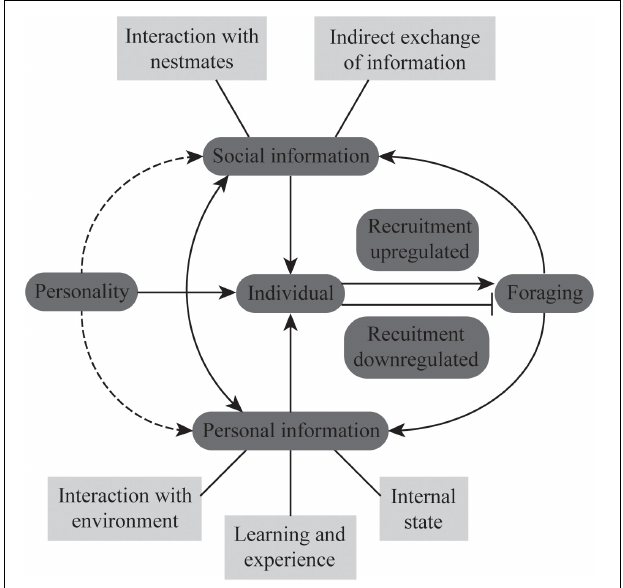
FIGURE 1 | The schematic represents the interplay between social and personal information and personality in regulating foraging behavior of individuals in ant colonies. The solid lines indicate known paths of interactions and the dotted lines indicate expected paths of interactions as discussed in the text. The arrowheads indicate the direction of the interaction. The different sources of information (social and personal) have been listed in the light gray boxes. The foraging decisions of individuals will determine collective foraging at the level of the